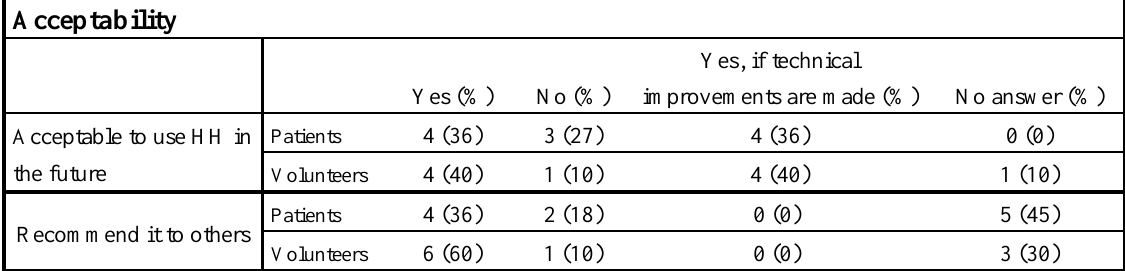
Yes, if technical Yes (%) No (%) improvements are made (%)